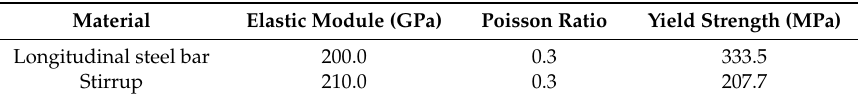
Table 3. Material parameters of FRP/concrete interface Figure 7. Stress-strain curve of steel. Figure 7. Stress-strain curve of steel. Table 4. Material parameters of steel. Table 4. Material parameters of steel.